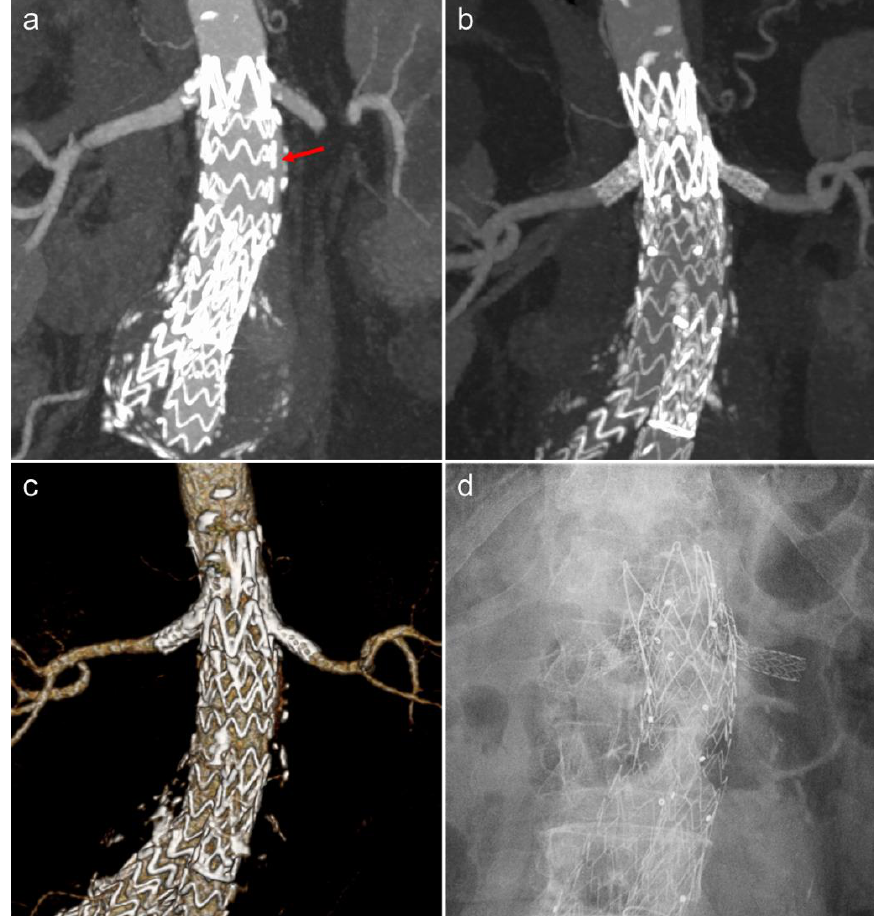
Figure 3. ( a ) AP coronal maximum-intensity projection (MIP) image of a patient with a type 1a endoleak (red arrow) post-EVAR. The patient underwent chimney stent grafts to both renal arteries with an aortic cuff extending above the renal arteries to create a new proximal neck seal. Coronal MIP ( b ), volume-rendered CT ( c ), and abdominal radiograph ( d ) showing the chimney EVAR.